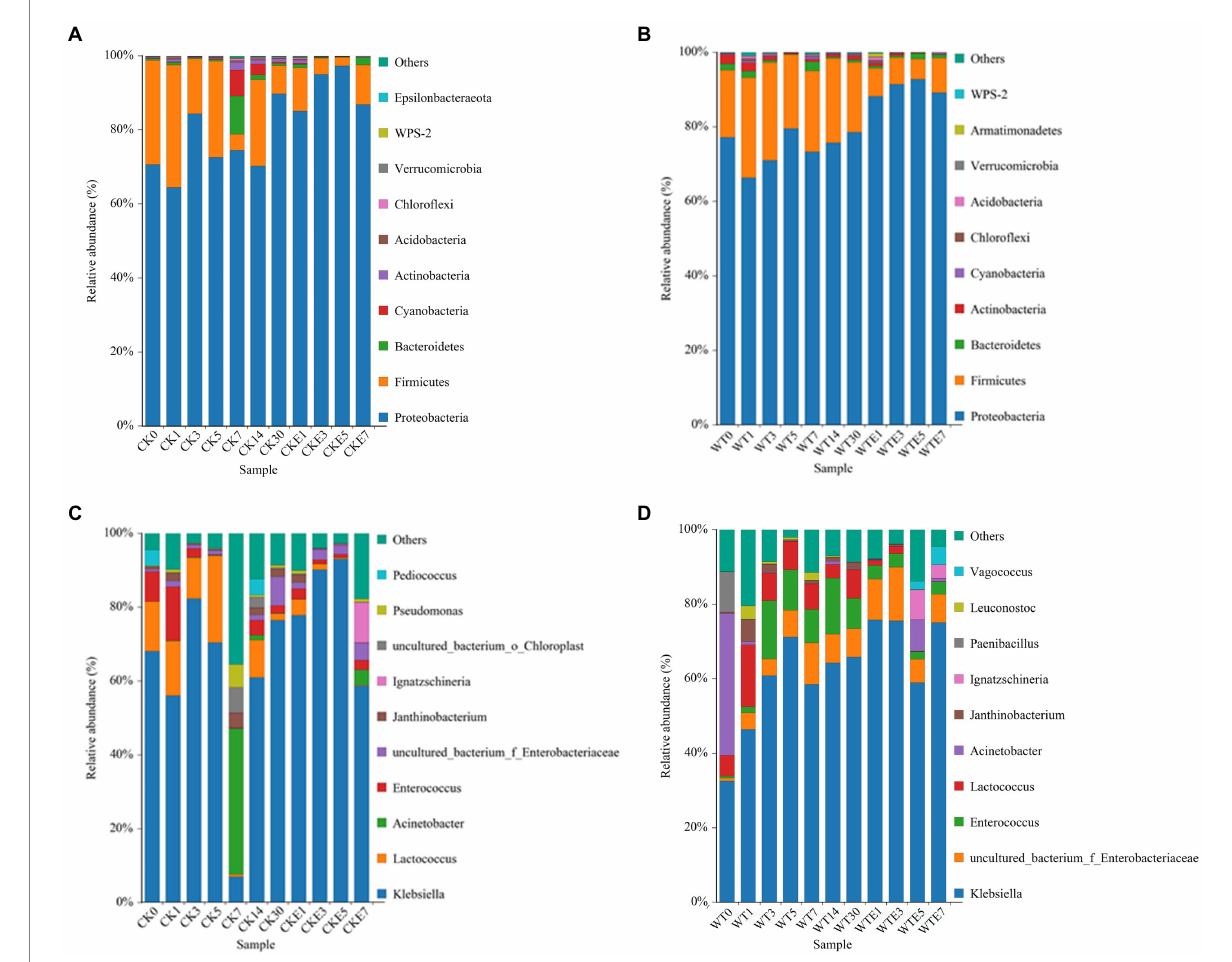
FIGURE 1 Relative abundance of bacterial community during ensiling and aerobic exposure of King grass silage. (A,C) show the relative abundance at phylum and genus level for CK, respectively, while (B,D) show the relative abundance at phylum and genus level for WT, respectively. CK, unwilted silage; CKE, unwilted silage aerobic exposure; WT, wilting silage; WTE, wilting silage aerobic exposure; Arabic numerals indicate the time of